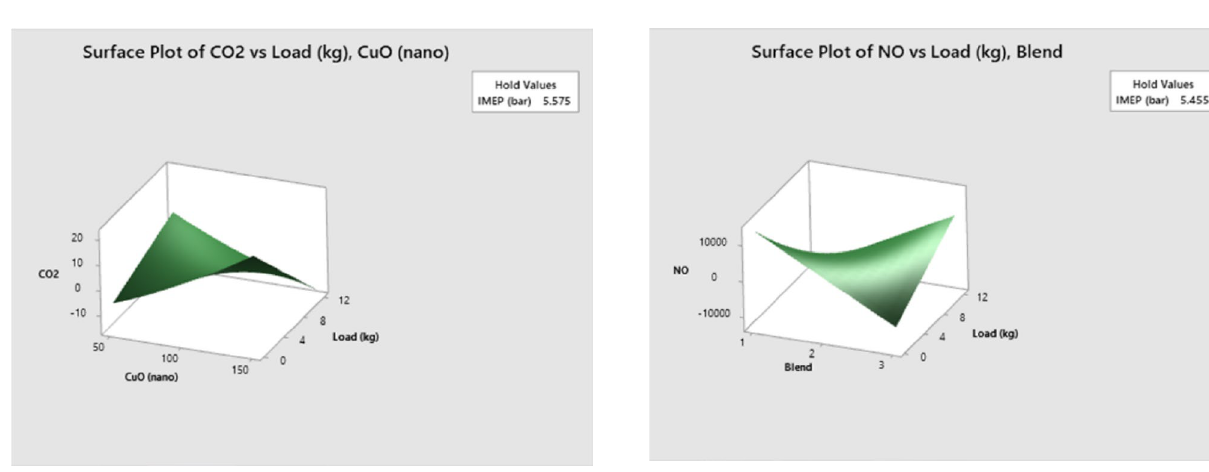
with nanoparticles 2